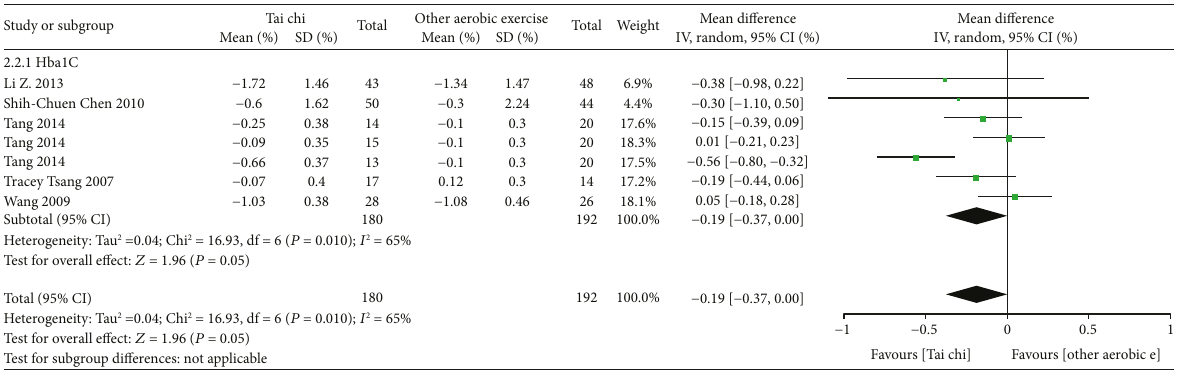
Test for overall effect: Z = 1.96 ( P = 0.05)